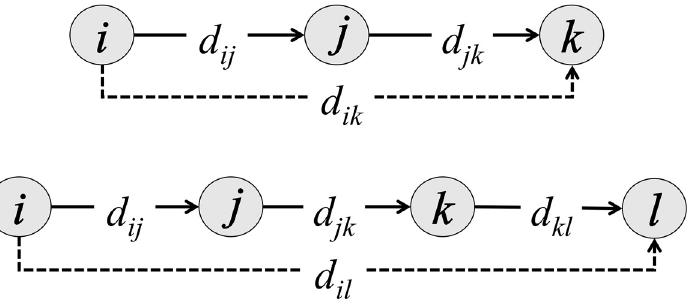
Fig 1. Illustration of aggression chains of length two and three. The d terms indicate the number of aggressive events between individuals i - l . The originator of the chain ( i ) is then linked through these indirect interactions to the terminal individual ( k or l ), and the dashed line indicates the association between the originator and the terminal individuals in the chain. For a chain length of two, W (2) quantifies the extent to which aggression along the chain ( d ij and d jk ) is a signal of rank difference between the originator and the terminal individual (dashed line); T (2) quantifies the extent to which aggression directed from the originator i to the terminal individual (dashed line) is higher, or lower, than average aggression by i , given aggression levels within the chain d ij and d jk